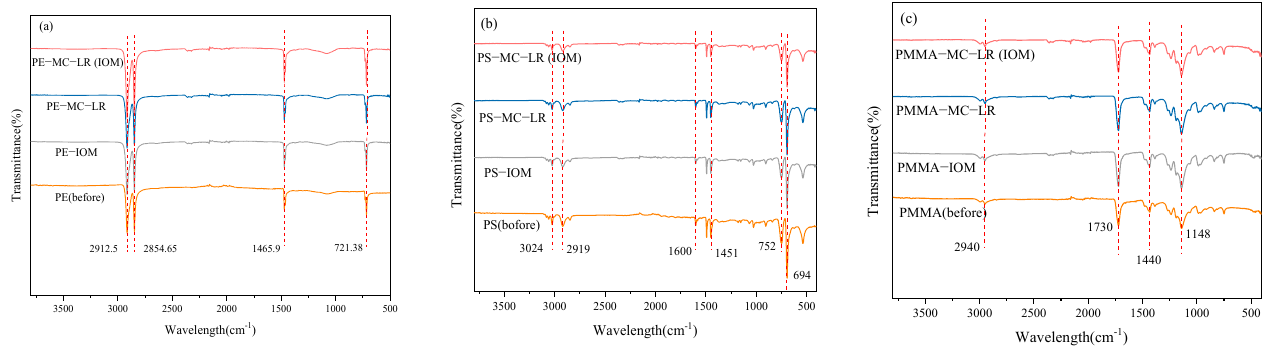
Figure 3. FTIR spectra of ( a ) PE; ( b ) PS, and ( c ) PMMA before and after adsorption of MC-LR